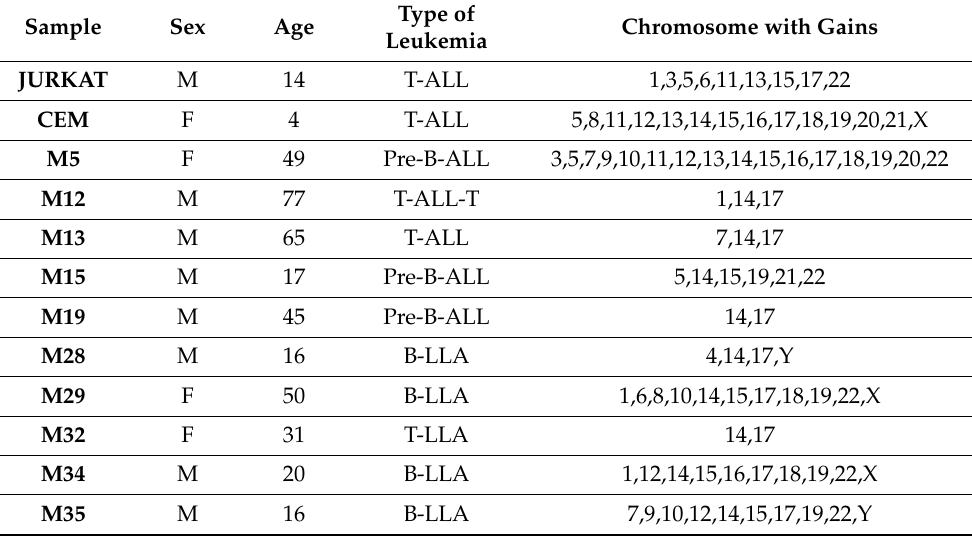
Table 2. Description of chromosomes that presented gain alterations in patients with ALL, including JURKAT and CEM leukemia-derived cell